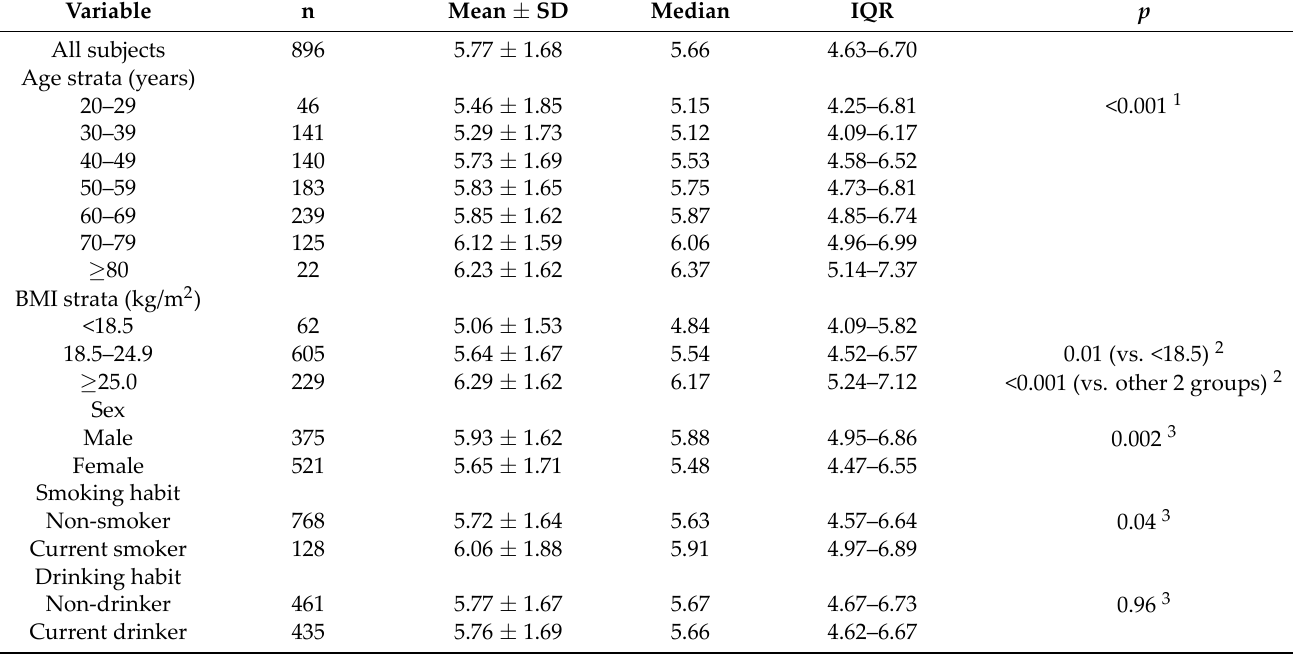
Table 2. Distribution of plasma lipopolysaccharide‑binding protein (LBP) concentration ( µ g/mL) and its relation to characteristics of participants.